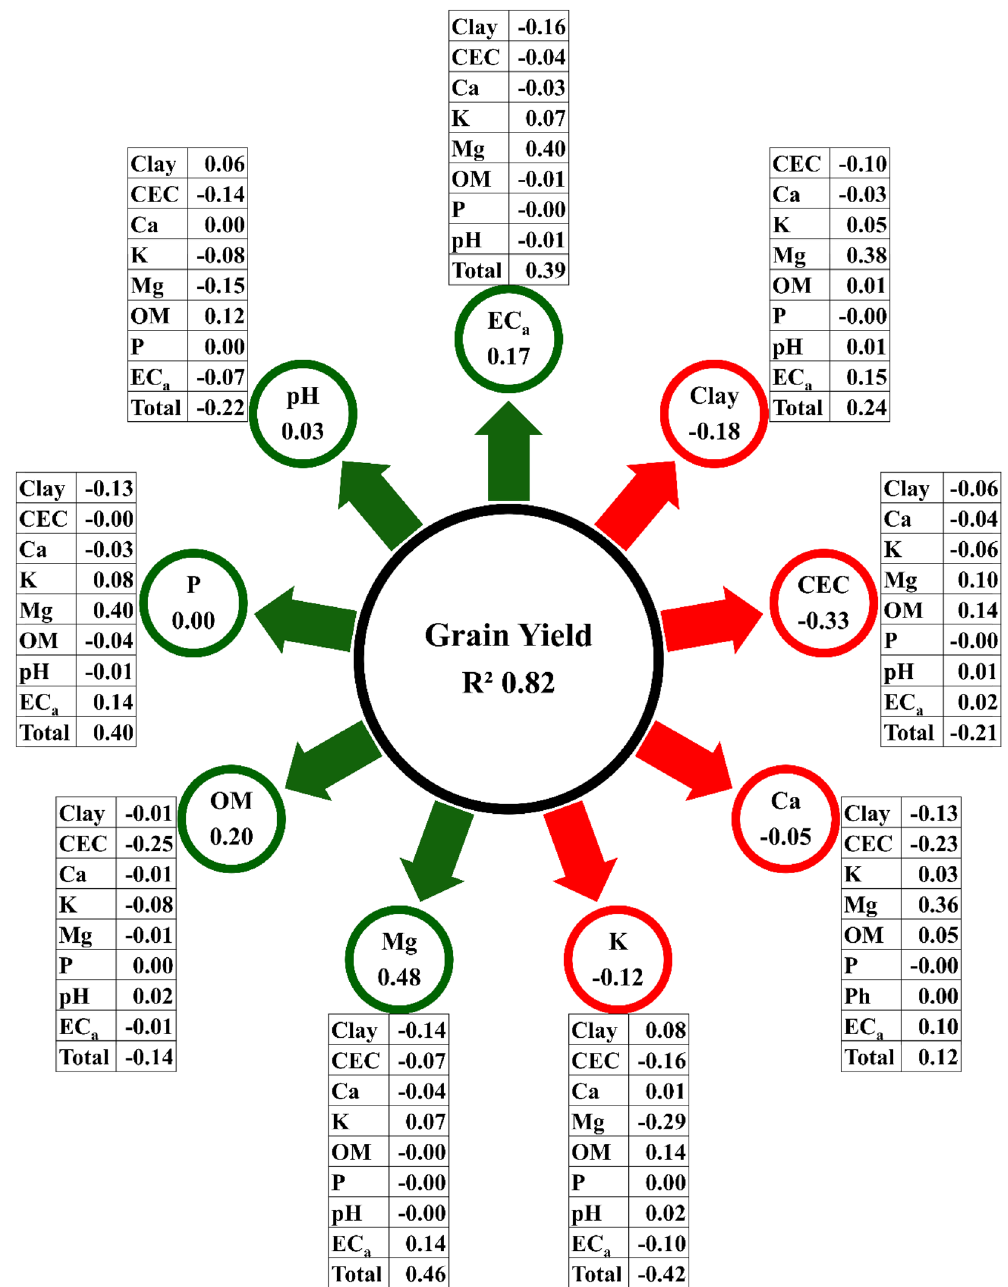
Figure 6. Path analysis of soil variables as a function of grain yield. Softwares used to create this figure were Genes (v1999.2019.44, http:// arqui vo. ufv. br/ dbg/ genes/ gdown1. htm) and Corel draw (vX7, https:// www. corel.